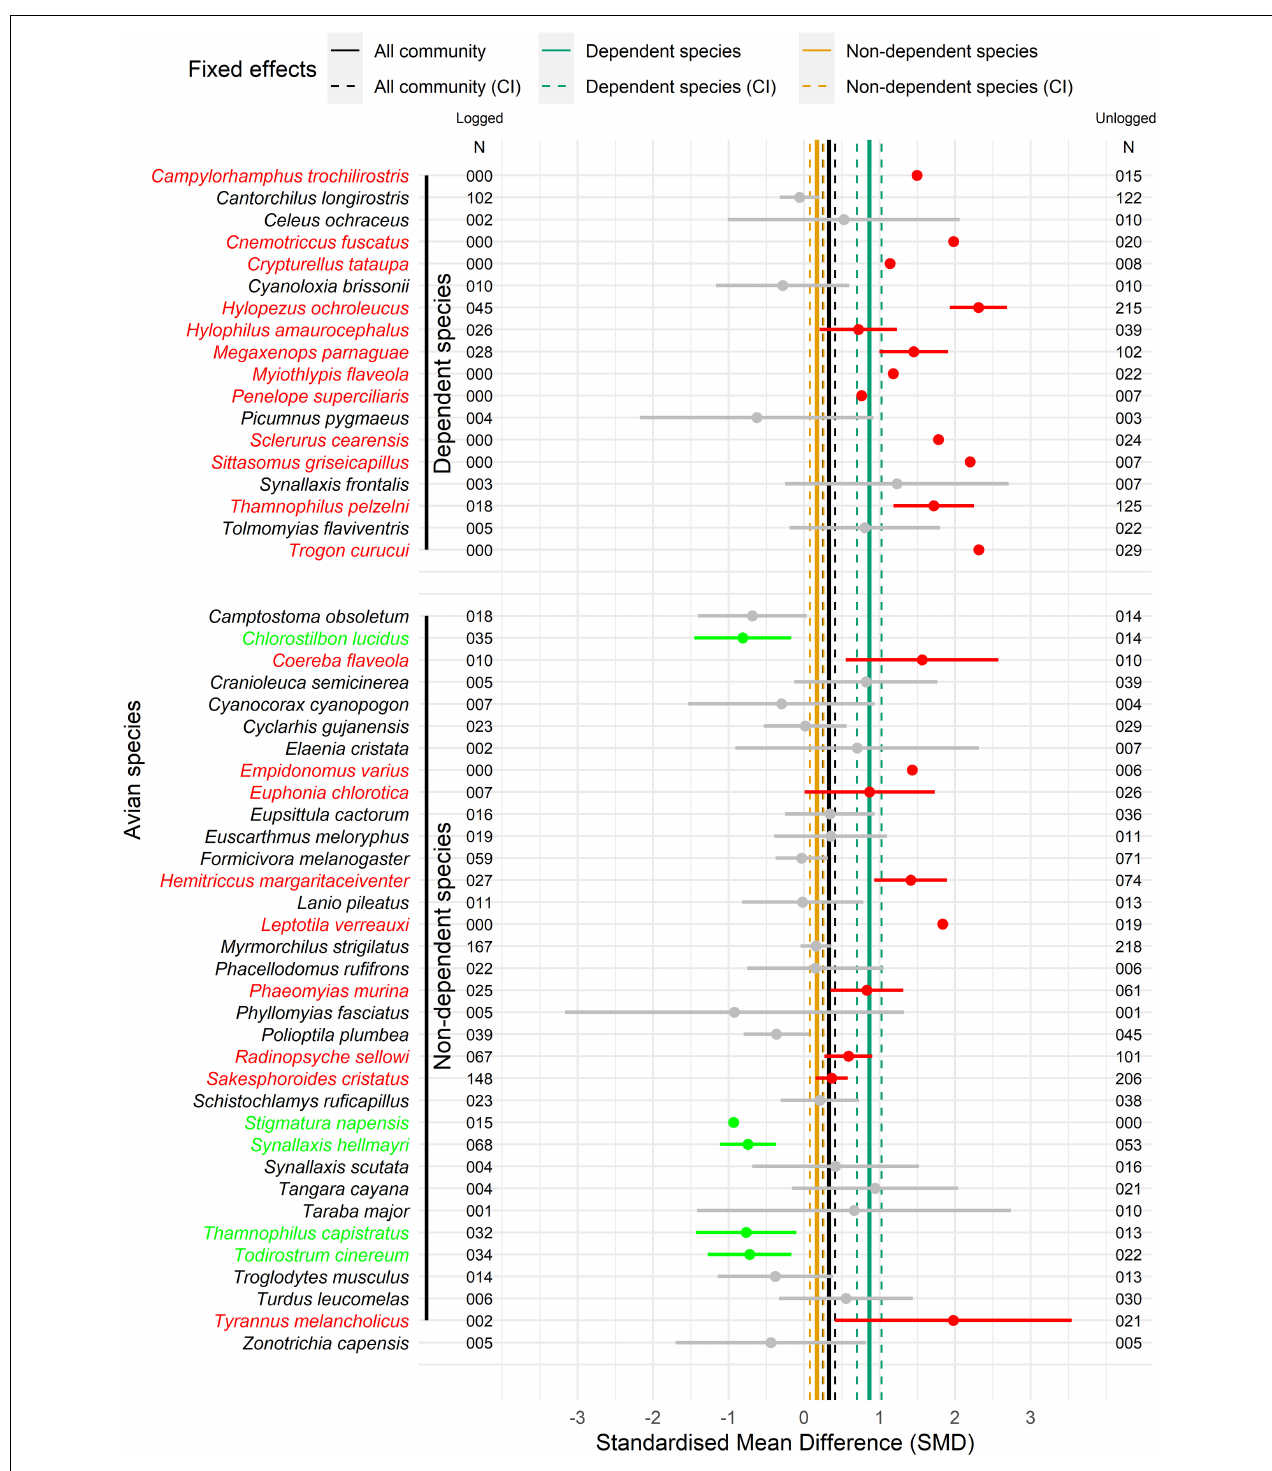
FIGURE 4 | Forest plot of bird species for standardized mean difference (SMD) in number of individuals (N) between logged and unlogged forest stands (excluding transition stands), and respective standard deviations. Were analyzed only bird species with more than five individuals recorded in 23 half-trails of the management area at the Fazenda Pau D’Arco, Crato, Ceará, Brazil. Vertical solid lines represent the fixed effects models from all community, from dependent species and non-dependent species, and vertical dashed lines indicated respective confidence intervals (CI). Red names and point ranges indicated species statistically more abundant in unlogged forest stands and green names and point ranges represents species more abundant at logged stands. Species points without ranges are recorded only in one group of forest stands and the standard deviations are zero.